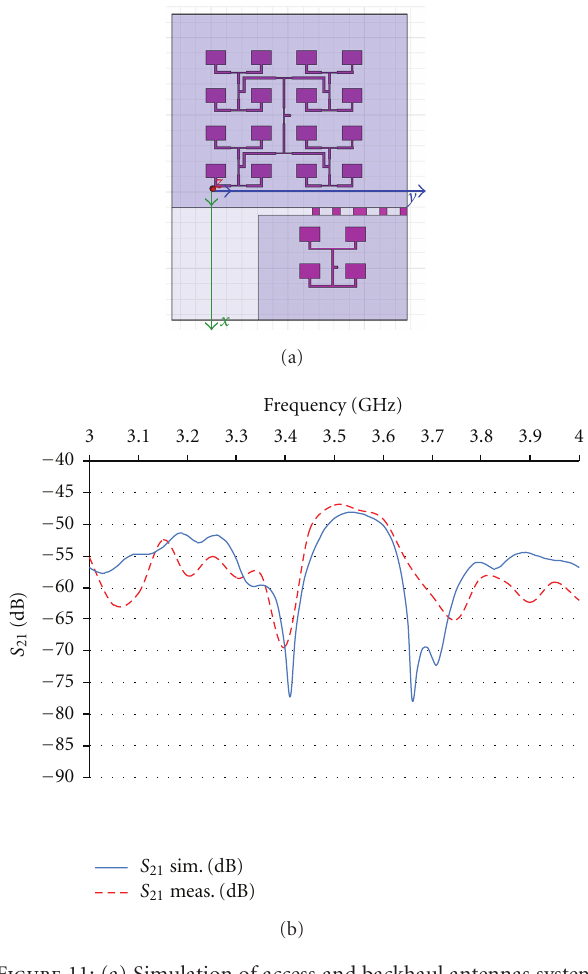
Figure 11: (a) Simulation of access and backhaul antennas system for configuration 1 ( ω = 180 ◦ ). (b) Simulation and experiment S 21 for ω = 180 ◦ .